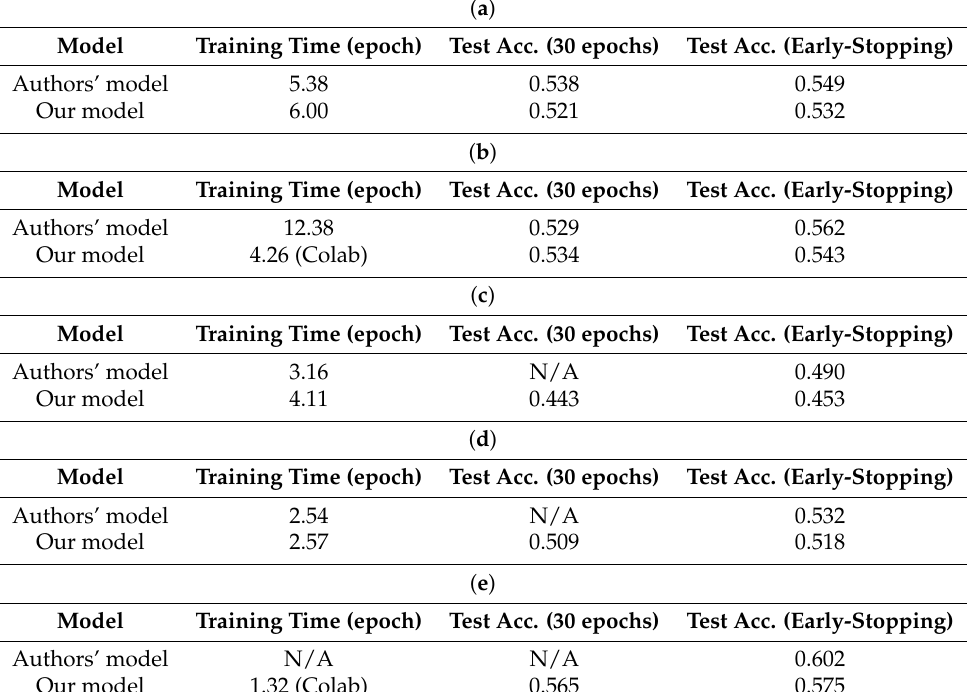
Table 6. Training times and performance for each model. ( a ) BERT BASE results for classification task on SST-5 root nodes. ( b ) BERT LARGE results for classification task on SST-5 root nodes. ( c ) AlBERT results for classification task on SST-5 root nodes. ( d ) DistilBERT BASE results for classification task on SST-5 root nodes. ( e ) RoBERTa LARGE results for classification task on SST-5 root